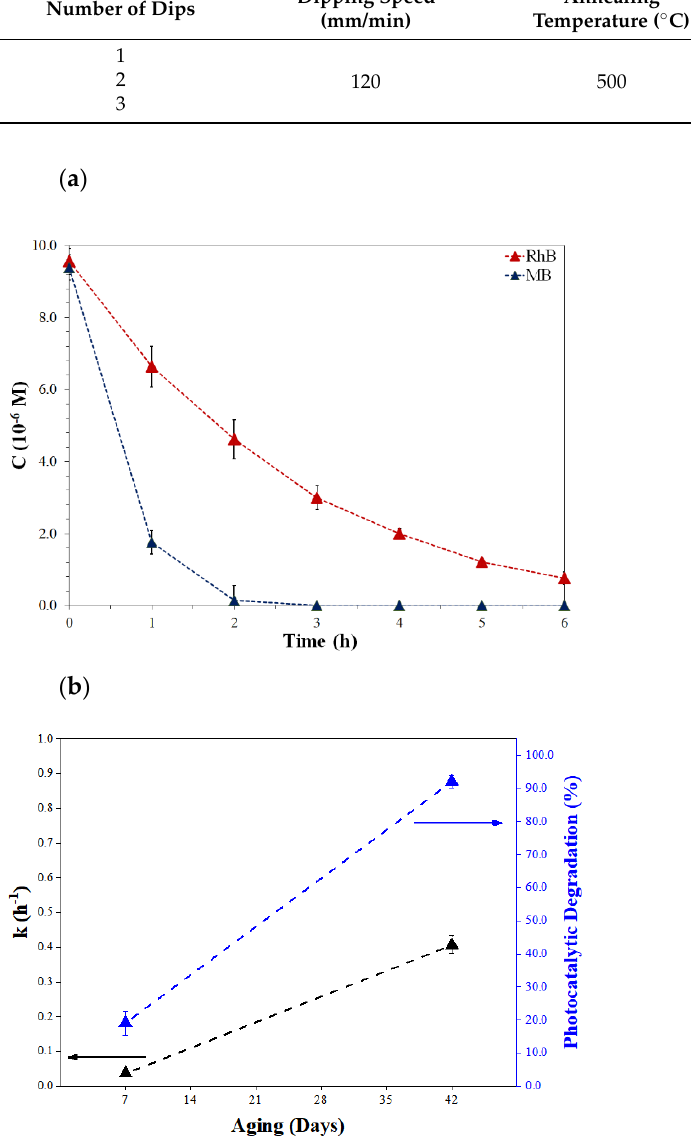
Figure 4. ( a ) RhB and MB concentration profiles versus irradiation time in presence of reference photocatalyst. ( b ) Effect of sol aging on photocatalysis kinetics of rhodamine B and its degradation percentage.